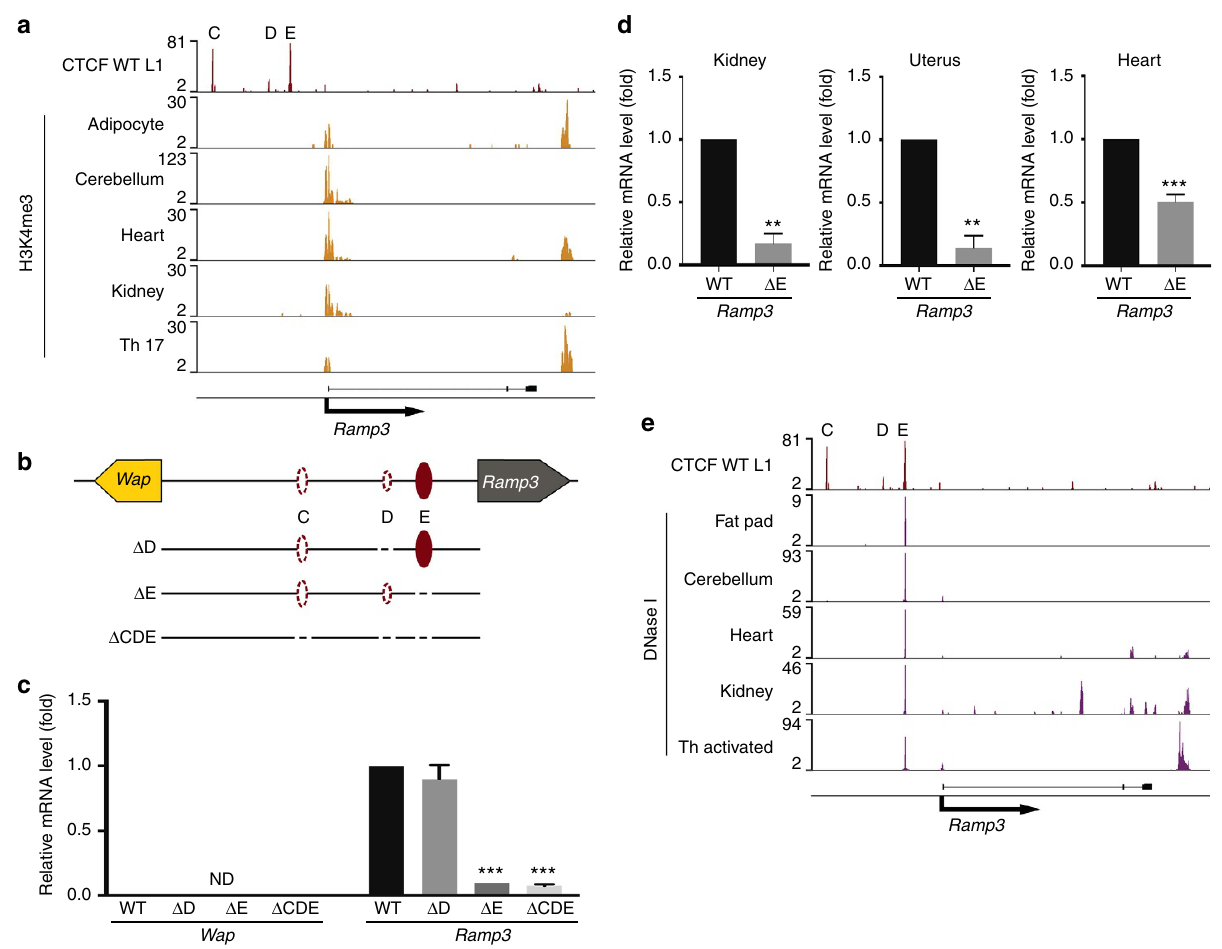
Figure 8 | Border CTCF site is required for Ramp3 expression in non-mammary cells. ( a ) H3K4me3 marks at the Ramp3 promoter indicated active transcription in several non-mammary cell types and tissues (GSE29218, GSE31039, GSE32864). ( b ) Out of the three CTCF-binding sites in mammary tissue that separate the Wap super-enhancer and Ramp3 , only site E (filled crimson ovals) was present in non-mammary tissue, like cerebellum, heart, kidney and uterus. CTCF binding to sites C and D was absent in those tissues (dashed crimson ovals) ( c ) Deletion of site E as well as the combined deletion of sites C, D and E led to a 90% reduction in Ramp3 expression in the cerebellum. Deletion of site D did not affect Ramp3 expression. Results are shown as the means ± s.e.m. of independent biological replicates; D D: n ¼ 3 ( (cid:2) / (cid:2) ); D E: n ¼ 6 ( (cid:2) / (cid:2) ); D CDE: n ¼ 4 ( (cid:2) / (cid:2) ); data were normalized to Gapdh ; one- way ANOVA with multiple comparison and alpha 0.01 was applied. * P o 0.01, ** P o 0.001, *** P o 0.0001. ( d ) Deletion of site E led to a significant reduction in Ramp3 expression in several non-mammary cells. Results are shown as the means ± s.e.m. of independent biological replicates; Kidney and Uterus D E: n ¼ 3 ( (cid:2) / (cid:2) ); Heart D E: n ¼ 4 ( (cid:2) / (cid:2) ); data were normalized to Gapdh ; a two-tailed Student’s t -test with alpha 0.01 was applied. * P o 0.01, ** P o 0.001, *** P o 0.0001. ( e ) CTCF site E coincided with DNase I hypersensitivity. Sites C and D were not occupied by CTCF in non-mammary cells and no DNase I hypersensitivity had been detected at these sites (GSE37074). ligase (New England Biolabs) was added to each sample and incubated for synthesized using SuperScript II (Invitrogen). Libraries for sequencing were pre- overnight at 16 (cid:2) C. Ligated samples were treated overnight with proteinase K pared according to the manufacturer’s instructions with TruSeq Stranded Total RNA Library Prep Kit with Ribo-Zero (Illumina, RS-122-2201) and paired-end sequencing was done with a HiSeq 2000 instrument (Illumina).